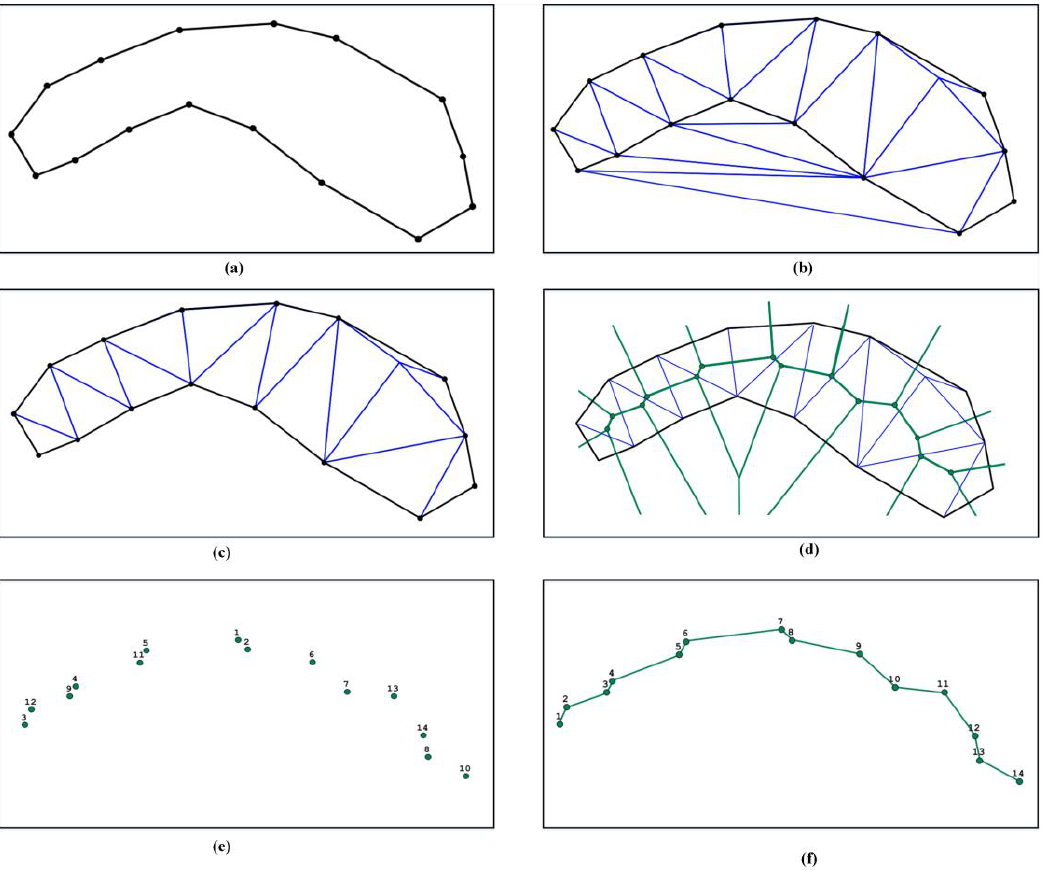
Figure 15. The medial axis approximation using the Voronoi diagram method: ( a ) a sample point of the shape boundary; ( b ) Delaunay triangulation of the boundary points; ( c ) discarding triangles that are outside the shape; ( d ) applying the Voronoi diagram; ( e ) extracting the Voronoi diagram vertices; and ( f ) connecting the Voronoi diagram’s vertices based on Algorithm 2.